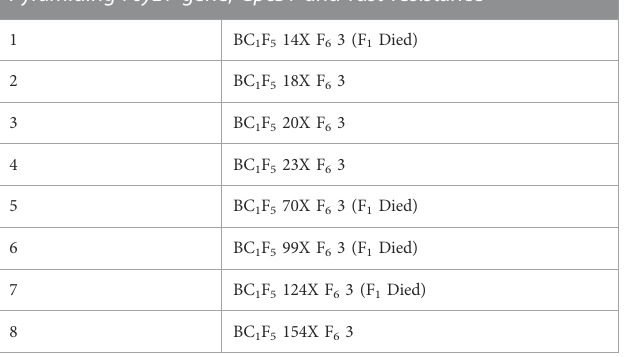
TABLE 1 Crosses made for pyramiding PsyE1 gene and GpcB1 gene. Pyramiding PsyE1 gene, GpcB1 and rust